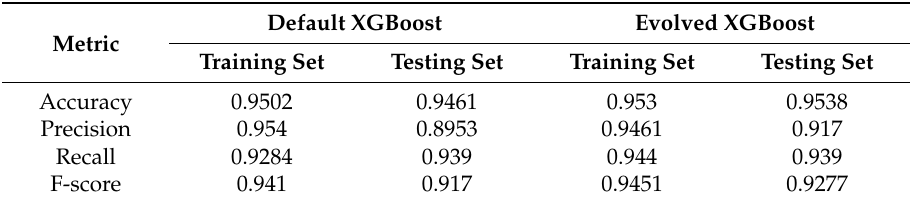
Table 12. Performance of evolved XGBoost classifier on training and testing sets.